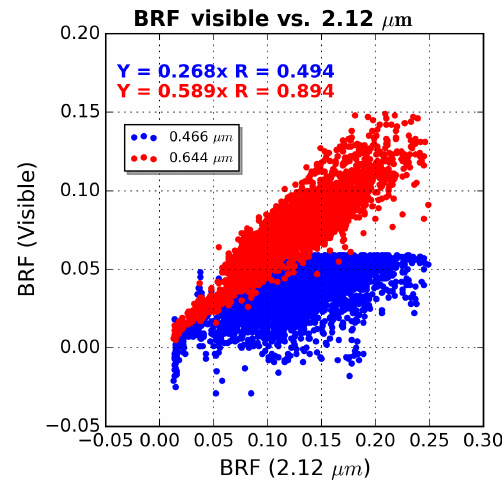
Figure 3. The BRF ratios of visible (0.466 and 0.644µm) to 2.12µm wavelength, filtered by the dark surface under AOD < 0.2. The ra- tios are obtained by forcing linear regressions through the